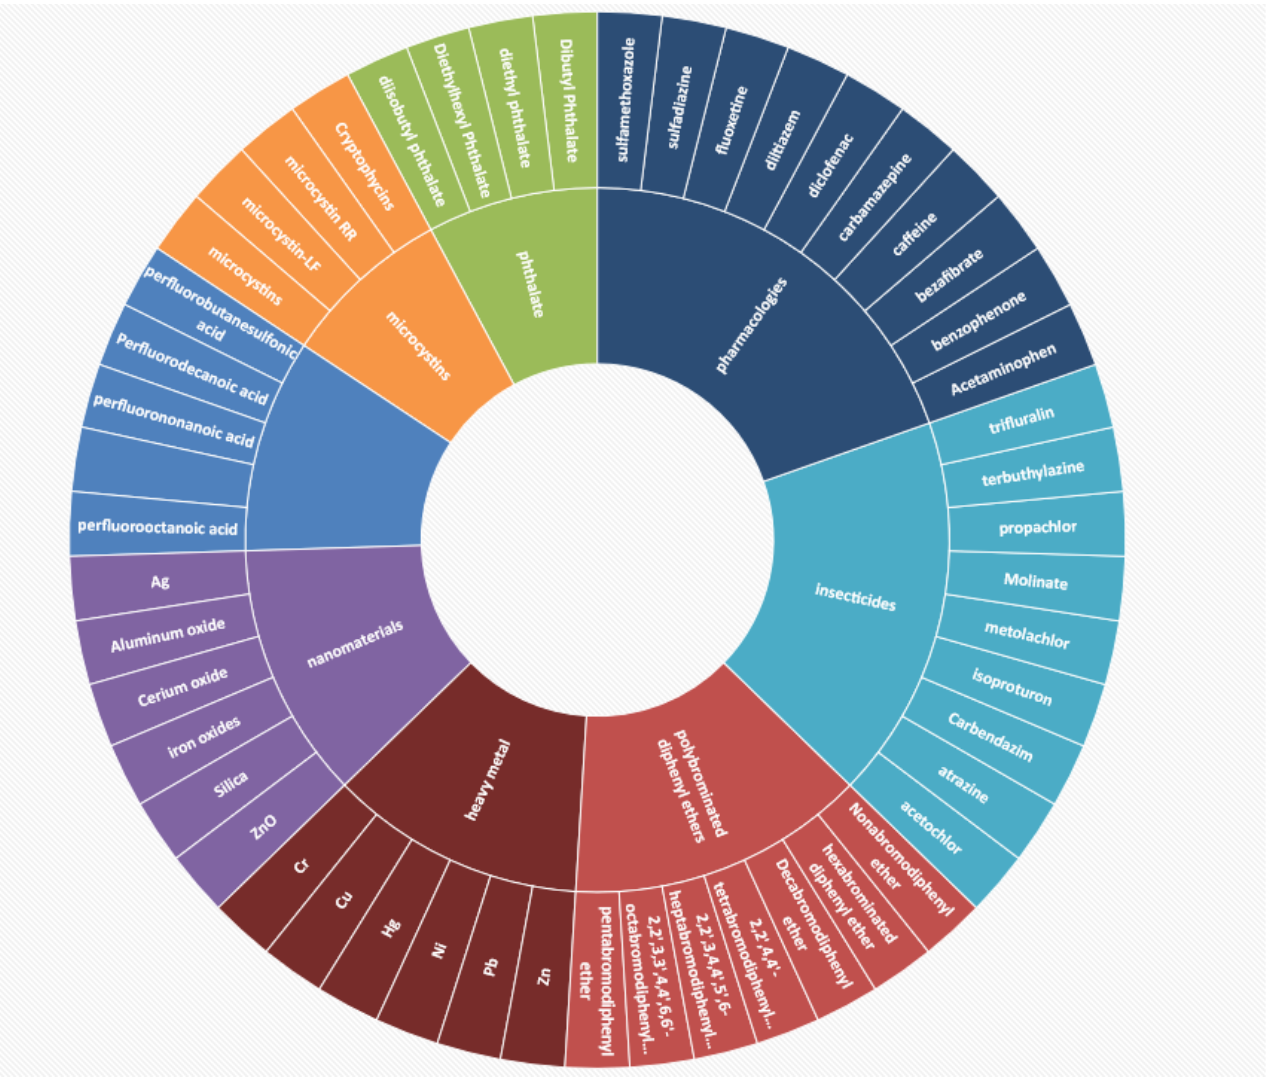
Figure 1. The most representative water pollutants analyzed in this work.